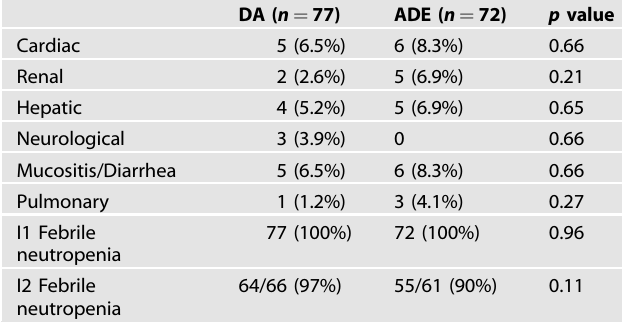
Table 4. Comparison of grade 3 – 5 toxicities between the two study